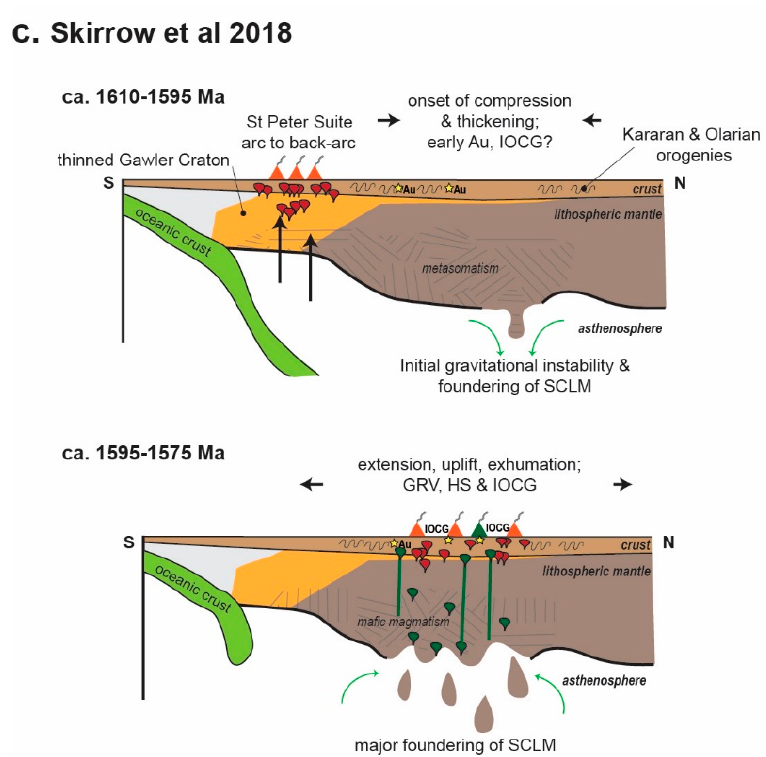
Figure 6. Examples of models for the tectonic setting of the Gawler Range Volcanics and Hiltaba Suite magmatism in the Gawler Craton and associated mineralisation in the Olympic Cu-Au Province. In each image, the current north is to the right of the diagram. Abbreviations used: GRV—Gawler Range Volcanics; HS—Hiltaba Suite; BVS—Benagerie Volcanic Suite; BS—Bimbowrie Suite. ( a ) Model of